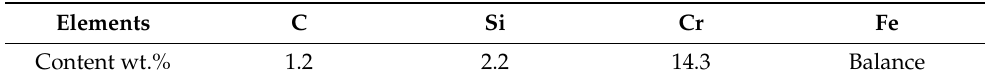
Table 1. Composition of Fe-based